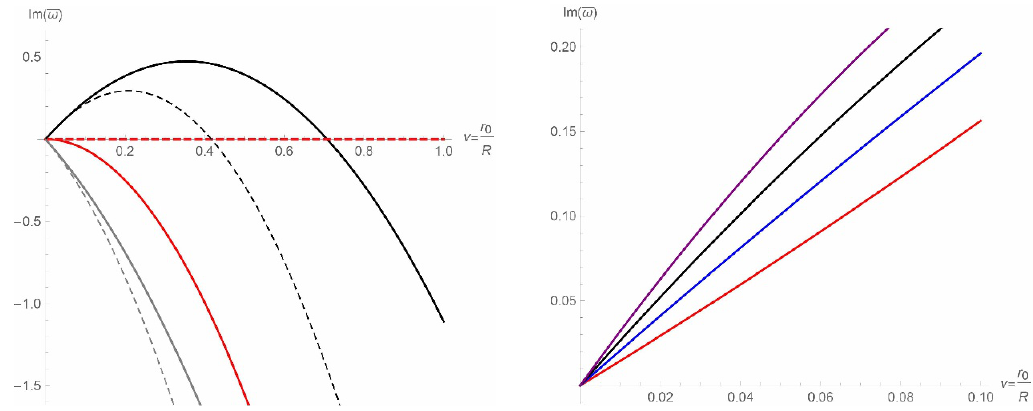
Figure 5 . On the left, we show the imaginary part of frequencies ! 2 (red solid line), ! 3 (black solid line) and ! 4 (grey solid line) for black rings up to (cid:12)rst order in derivatives as a function of the ring thickness (cid:23) = r 0 =R for D = 5 and m = 10 using the full expressions provided in the supplementary material. The dashed lines are the corresponding frequencies for boosted black strings in (3.7) with critical boost. On the right plot we show the behaviour of the imaginary part of ! 3 as a function of m for m = 6 (red), m = 8 (blue), m = 10 (black) and m = 12 (purple) for D =